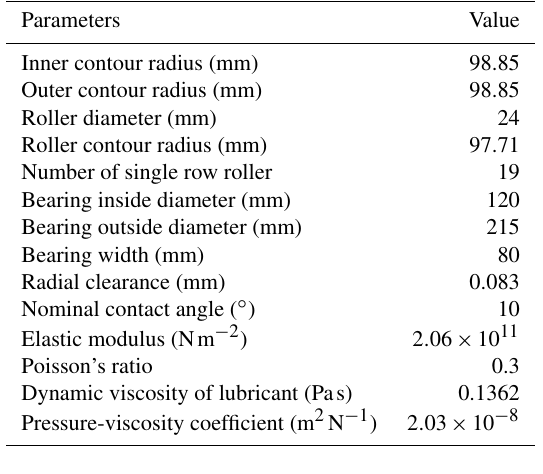
wheel supporting point. This vibration mode is related to the distribution of the concrete in the